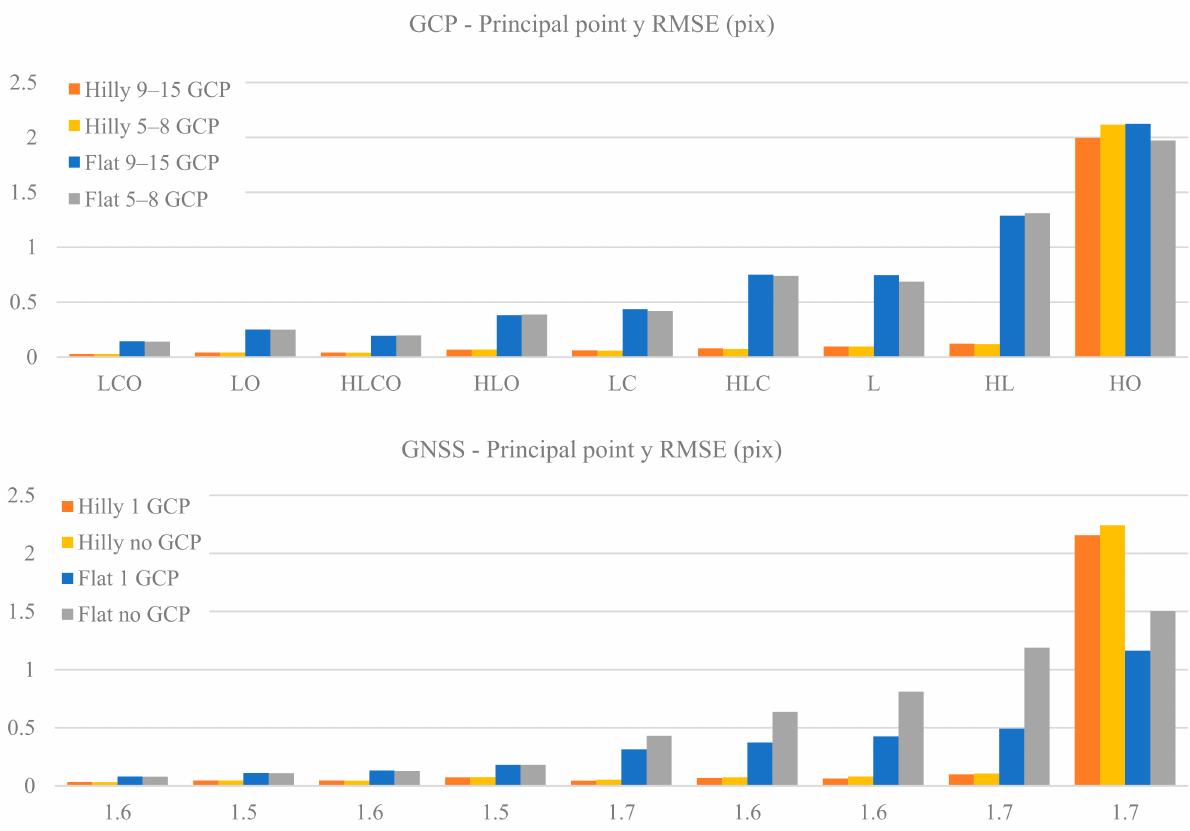
Figure 4. RMSE of the principal point x coordinate as a function of block configuration, terrain type (Flat, Hilly) and control tightness (Basic or Enhanced): ( top ): GCP case; ( bottom ): GNSS case.